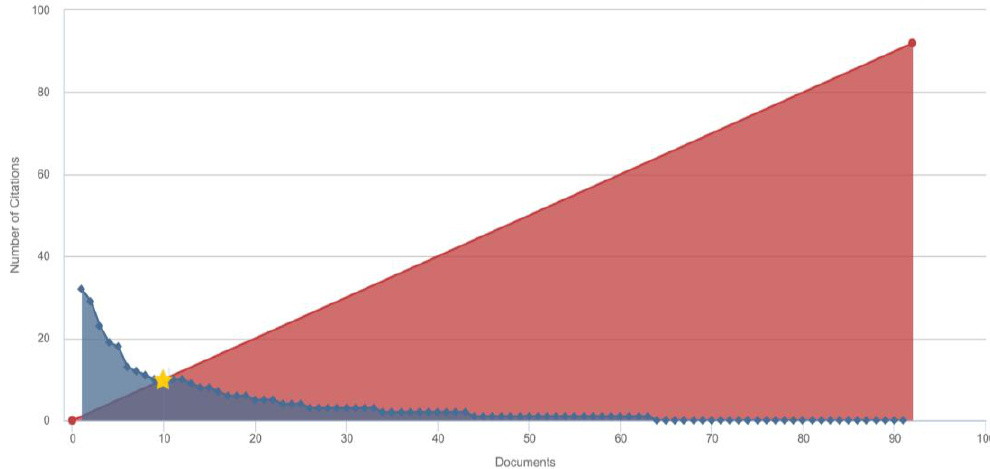
Fig. 8. Documents’ h-index ( Scopu s